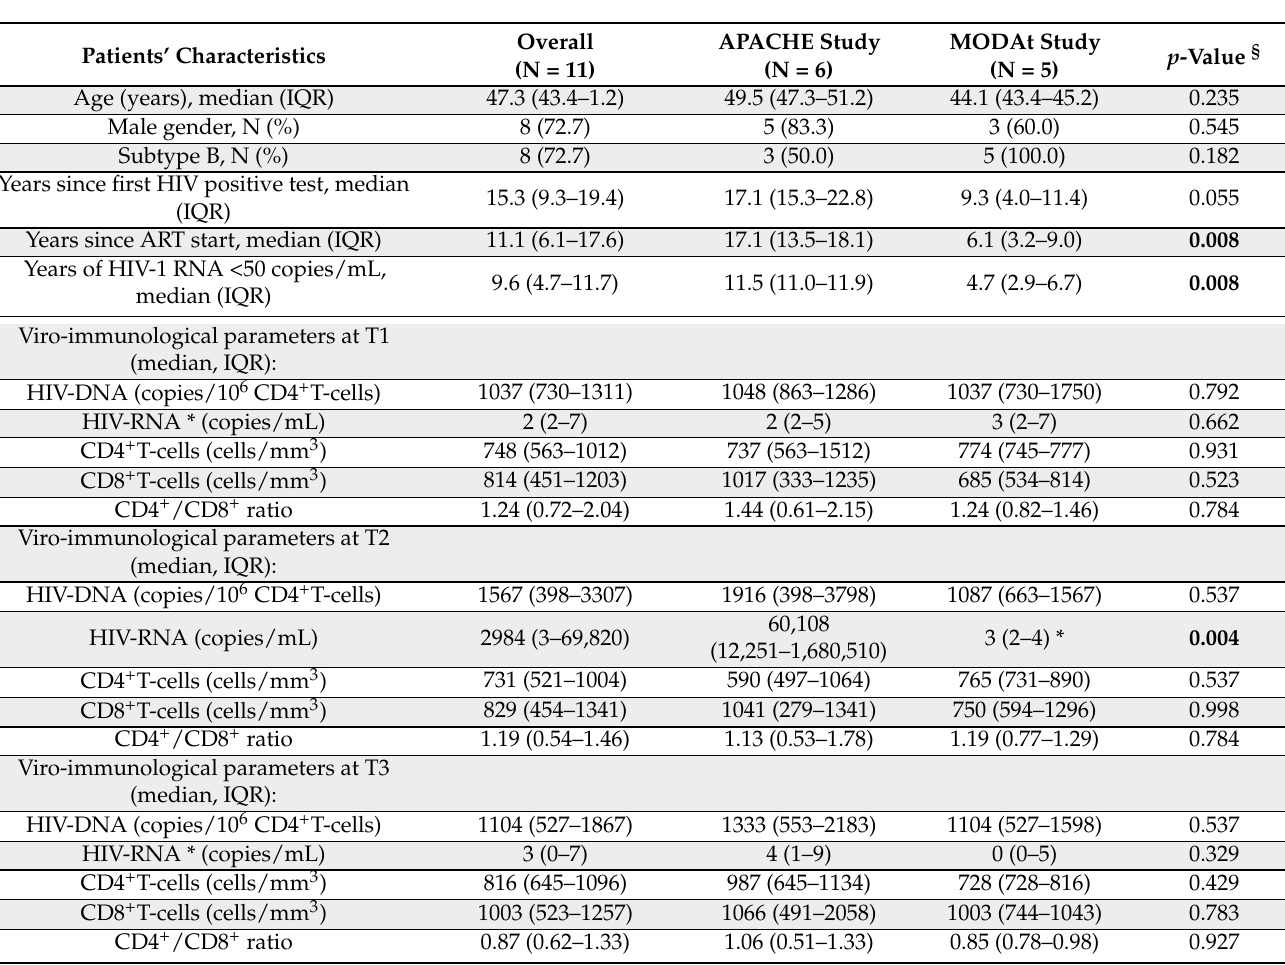
Table 1. Patients’